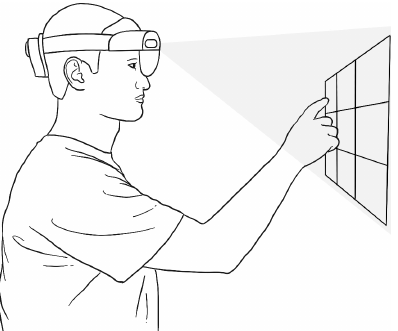
Figure 1. Target selection in OST AR environments.